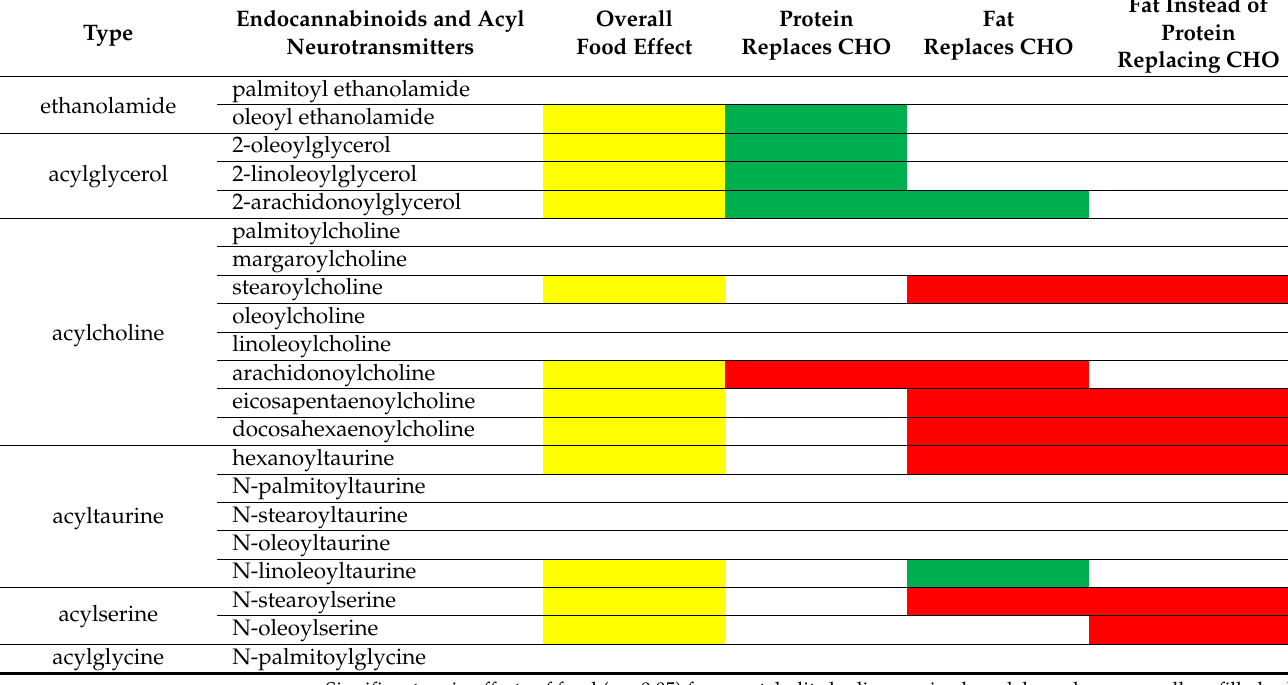
Table 13. Effects of foods on serum endocannabinoids and acylated neurotransmitters or amino